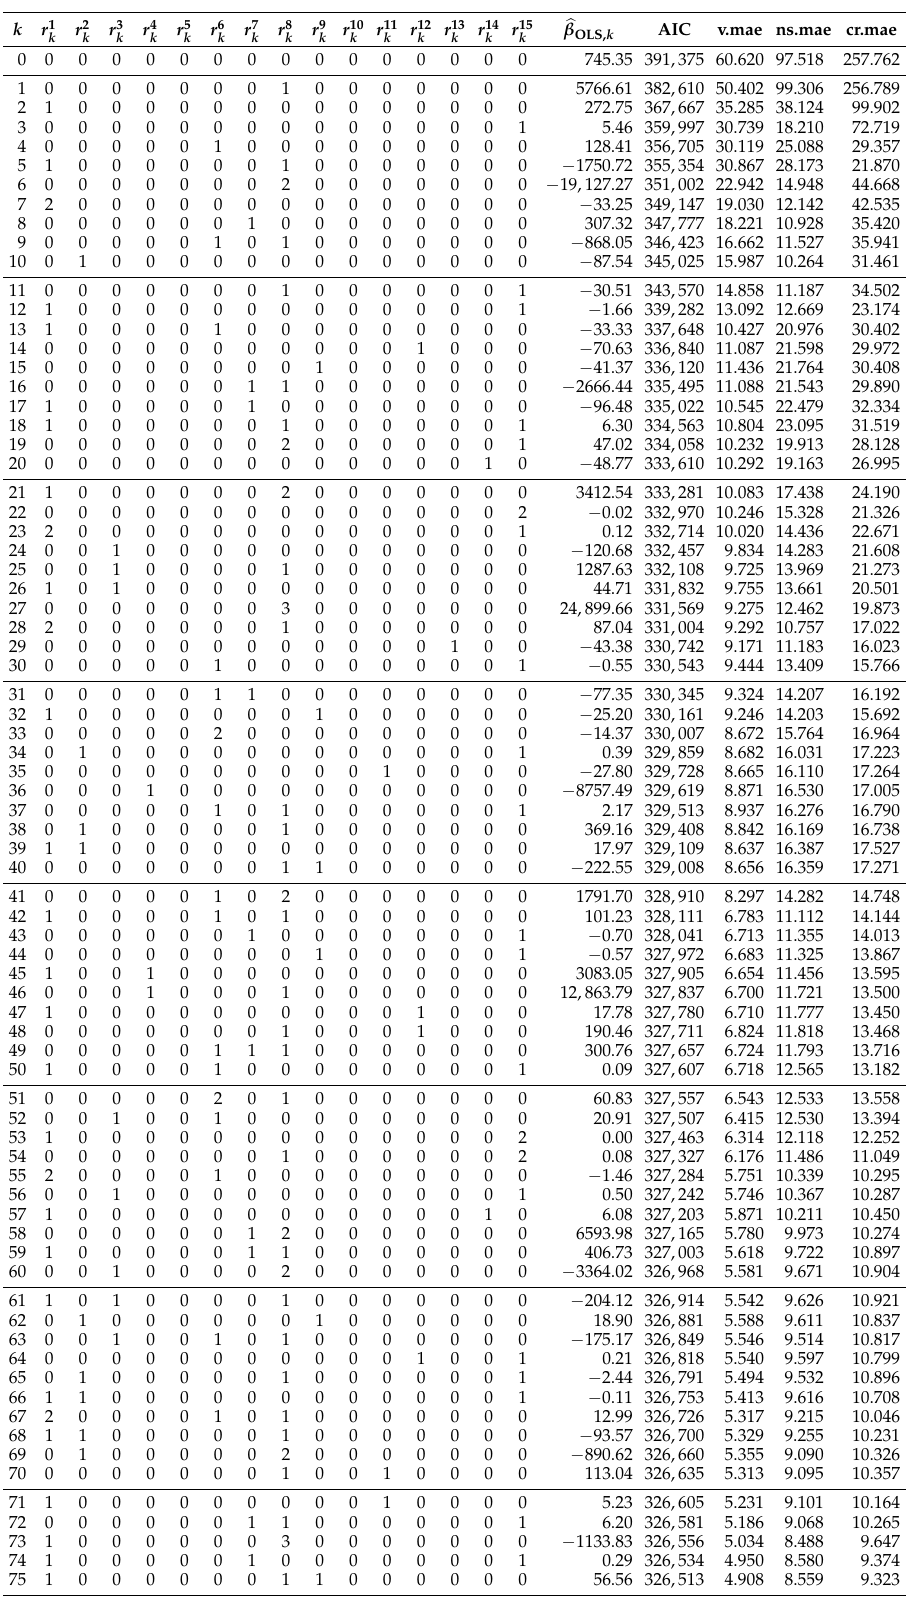
Table A2. OLS proxy function of available capital (AC) derived under 150–443 in the adaptive algorithm with the final coefficients. Furthermore, AIC scores and out-of-sample MAEs in % after each